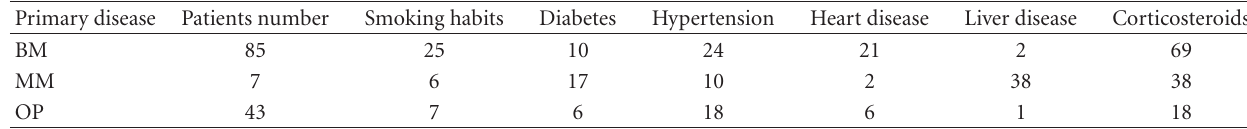
Table 2: Risk factors: smoking habits, diabetes, hypertension, heart disease comprehending coagulation disorders, liver disease, and corticosteroids administration; BM: bone metastasis, MM: multiple myeloma, OP: osteoporosis and/or rheumatoid arthritis.